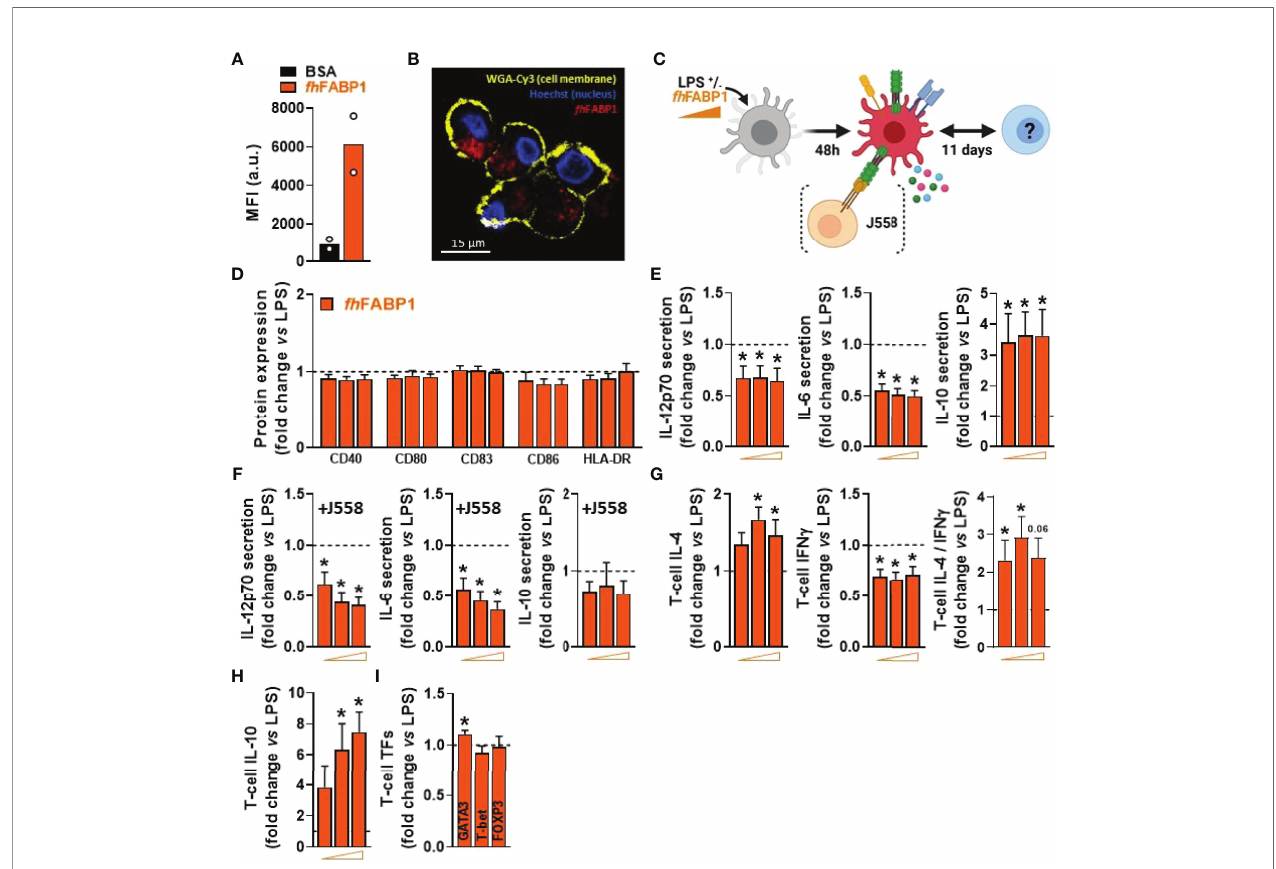
FIGURE 3 | Fasciola hepatica FABP1 reduces the in fl ammatory phenotype of LPS-stimulated dendritic cells and increases both Th2-on-Th1 ratio and IL-10- producing T cells. The binding of PF-647-labeled BSA-control (black bar) or recombinant fh FABP1 (orange bars) to monocyte-derived DCs (moDCs) was assessed after 2 hours by fl ow cytometry (A) The subcellular localization of PF-647-labeled recombinant fh FABP1 (depicted in red) in moDCs was determined after 4 hours by confocal microscopy and shown as 2D images of Z-planes with nuclear (Hoechst, depicted in blue) and membrane (WGA-Cy3, depicted in yellow) staining (B) One representative experiment is shown from 3 independent experiments Human moDCs were treated for 48 h with increasing concentration of fh FABP1 (10, 25, 50 µg/ ml) in presence of LPS (100 ng/ml) and either co-cultured with CD40-L-expressing cell line J558 for 24 hours or co-cultured with naïve CD4 + T cells for 11 days (C) The cell-surface expression of co-stimulatory molecules (D) and cytokines secretion by moDCs with (E) or without co-culture with J558 (F) were determined by fl ow cytometry and ELISA, respectively Conditioned moDCs were characterized for their capacity to prime CD4 + T cell responses, as described in Figure 1 (G) . One representative experiment is shown for the Zebra plot In addition, primed CD4 + T cells were restimulated with a -CD3 and a -CD28 to measure IL-10 production after 24 hours (H) and analysed for GATA3, T-bet, and FOXP3 transcription factor expression by fl ow cytometry (I) . All data are expressed relative to the DCs stimulated with LPS alone (dash line) as mean ± SEM * P ≤ 005 vs LPS alone (n=3-7 independent